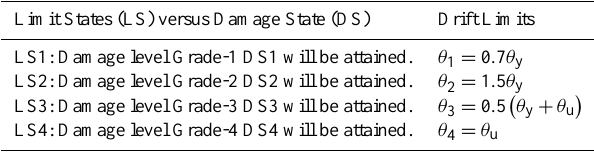
Table 2. Damage scale considered for fragility functions derivation. Limit States (LS) versus Damage State (DS) Drift Limits LS1: Damage level Grade-1 DS1 will be